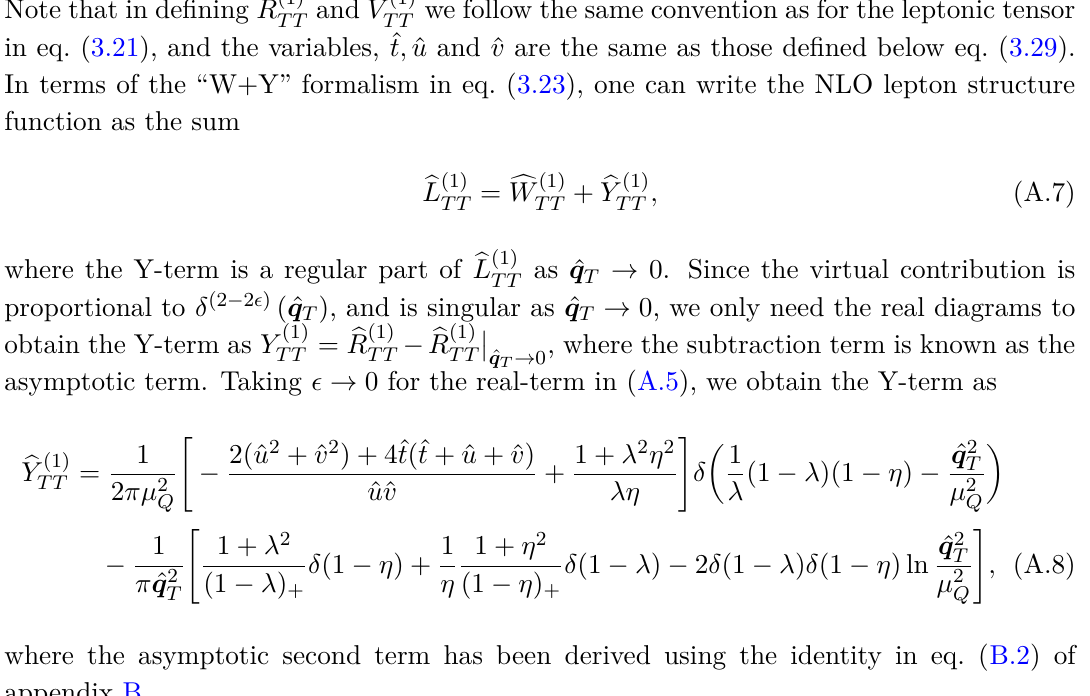
Figure 23 . Virtual correction diagram for the calculation of the leptonic tensor at NLO. The corresponding Hermitian conjugate diagram (omitted here) is also included in the